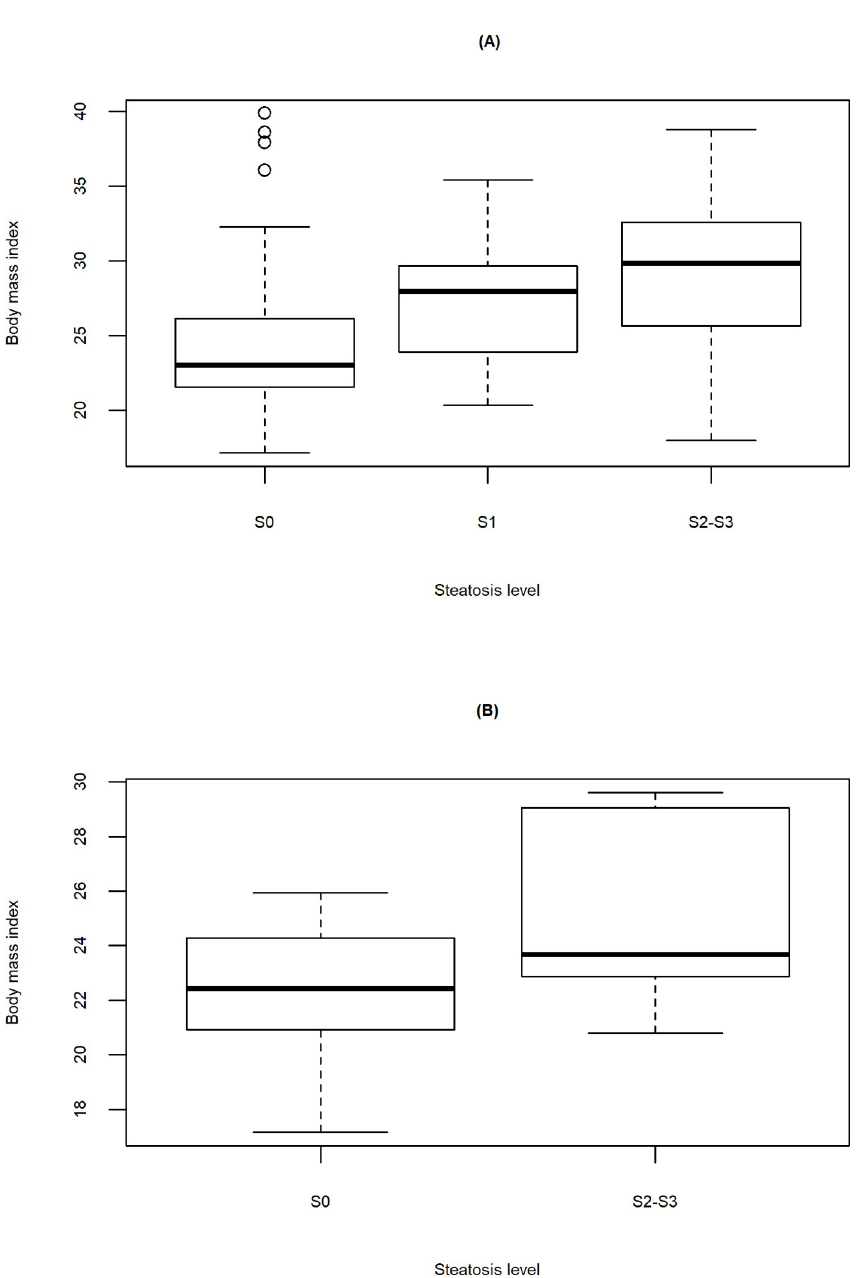
Fig 2. Body mass index by steatosis. Boxplots illustrate an increased trend of steatosis severity as body mass index increases for (A) all study participants and (B) HCV/HIV co-infected participants. S0 indicates healthy individuals, S1 indicates individuals with mild steatosis, and S2-S3 indicates individuals with medium or severe